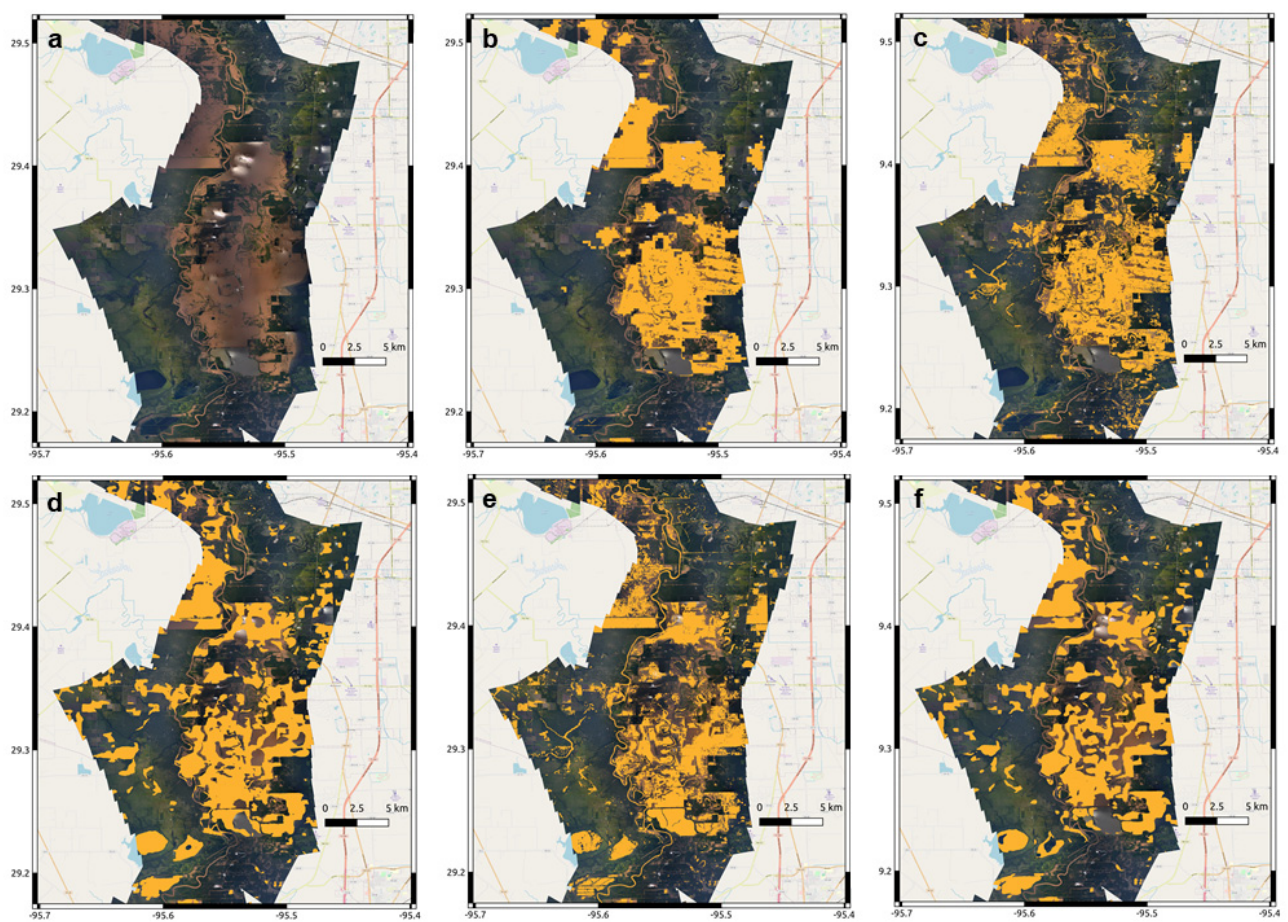
Figure 11. ( a ) NOAA Remote Sensing Division airborne digital optical imagery of the Houston area acquired between 27 August and 3 September 2017, subregion 1, as shown in Figure 2; ( b ) water pixels identified by DFO MODIS data, 250 m pixel spacing, courtesy of the DFO [41]; ( c ) water pixels identified from NDWI analysis of Sentinel-2 data, 10 m pixel spacing; ( d ) water pixels identified by the DeepLabv3+ analysis of SAR GRD data, 29 August 2017, 10 pixel spacing; ( e ) water pixels identified from thresholding analysis of the same SAR GRD data, 10 m pixel spacing; and ( f ) water pixels identified by the classification analysis of the SAR GRD data, 10 m pixel spacing. The GWM is not removed from the analyses of ( b ) through ( f ). Water pixels are shown in